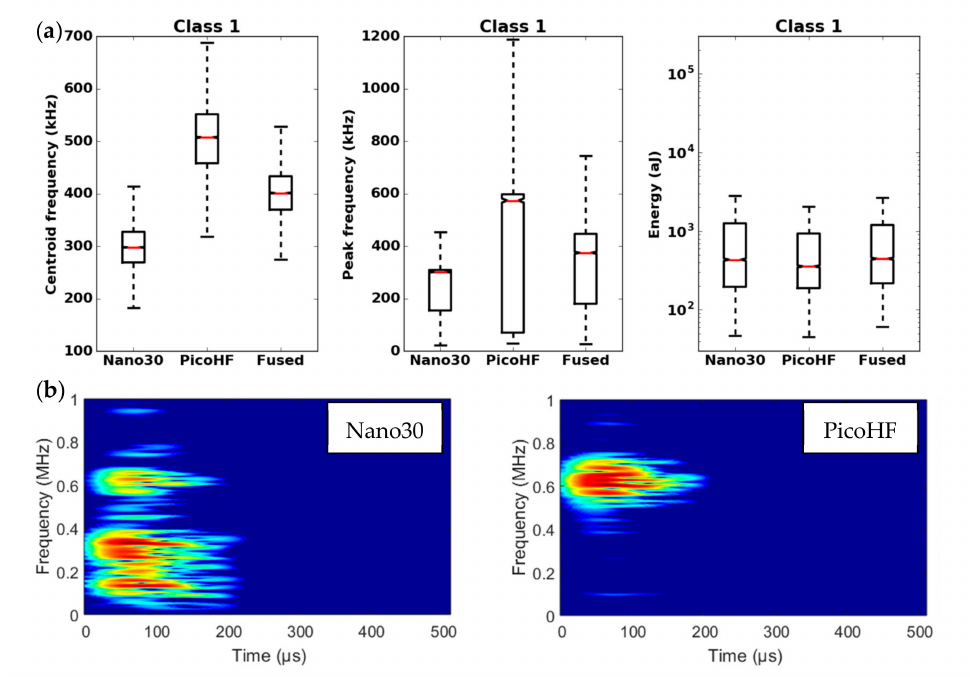
Figure 17. Results of the classification with an unsupervised classification based on fused features. ( a ) Characteristics of class 1 (frequency centroid, peak frequency and energy) viewed by the Nano30 sensor, PicoHF or with merged descriptors. ( b ) Representation in time / frequency domain with the Smoothed Pseudo Wigner-Ville Distribution (SPWVD) of the same AE signal recorded by Nano30 sensor and PicoHF sensor for class 1.